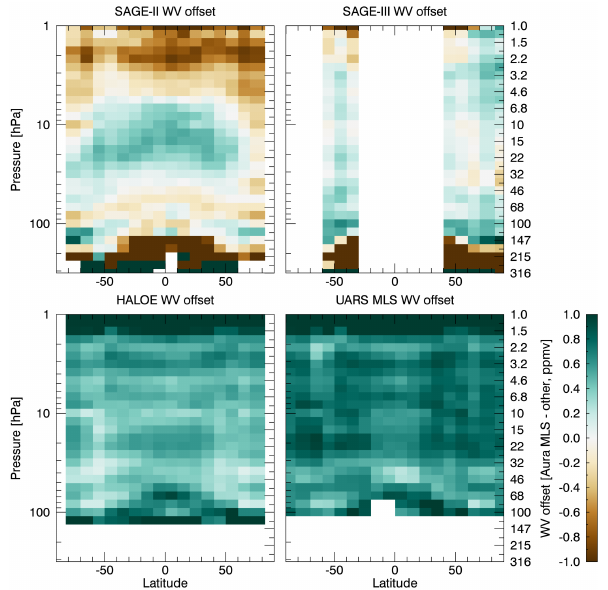
Figure 6. Same as Fig. 5 but for O 3 offsets, which are relative to the SAGE II